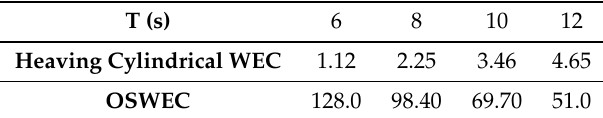
Table 2. Optimal linear B PTO coefficients for a heaving cylindrical WEC (10 6 × kg/s) and OSWEC (10 6 × (kg · m 2 )/s).